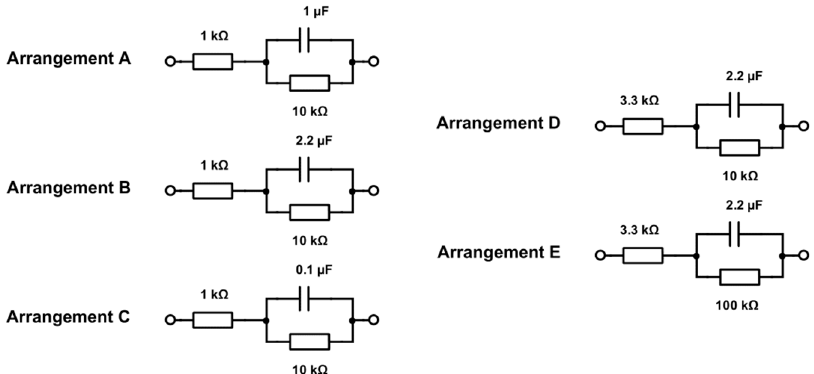
Figure 8. Five physical equivalent models (A—E) for characterization of the measurement setup and its calibration.